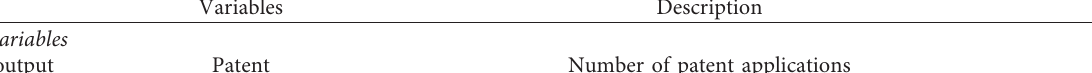
Table 1: Variable descriptive statistics.